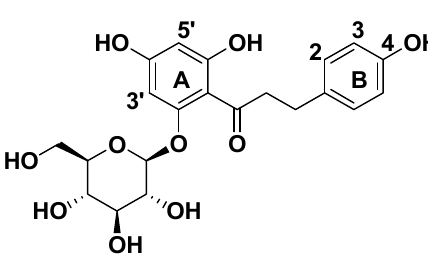
Figure 2. The structure of